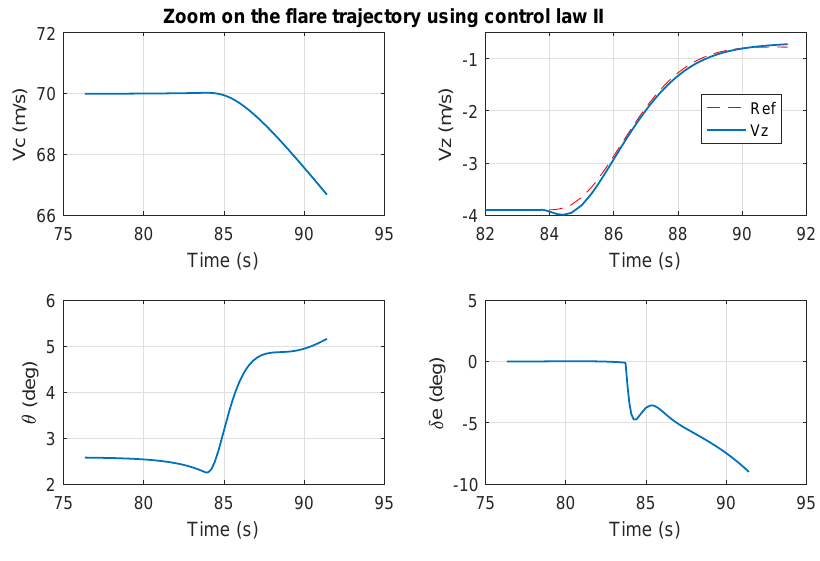
Figure 7. Flare trajectory with Control Law II (with speed feedback).